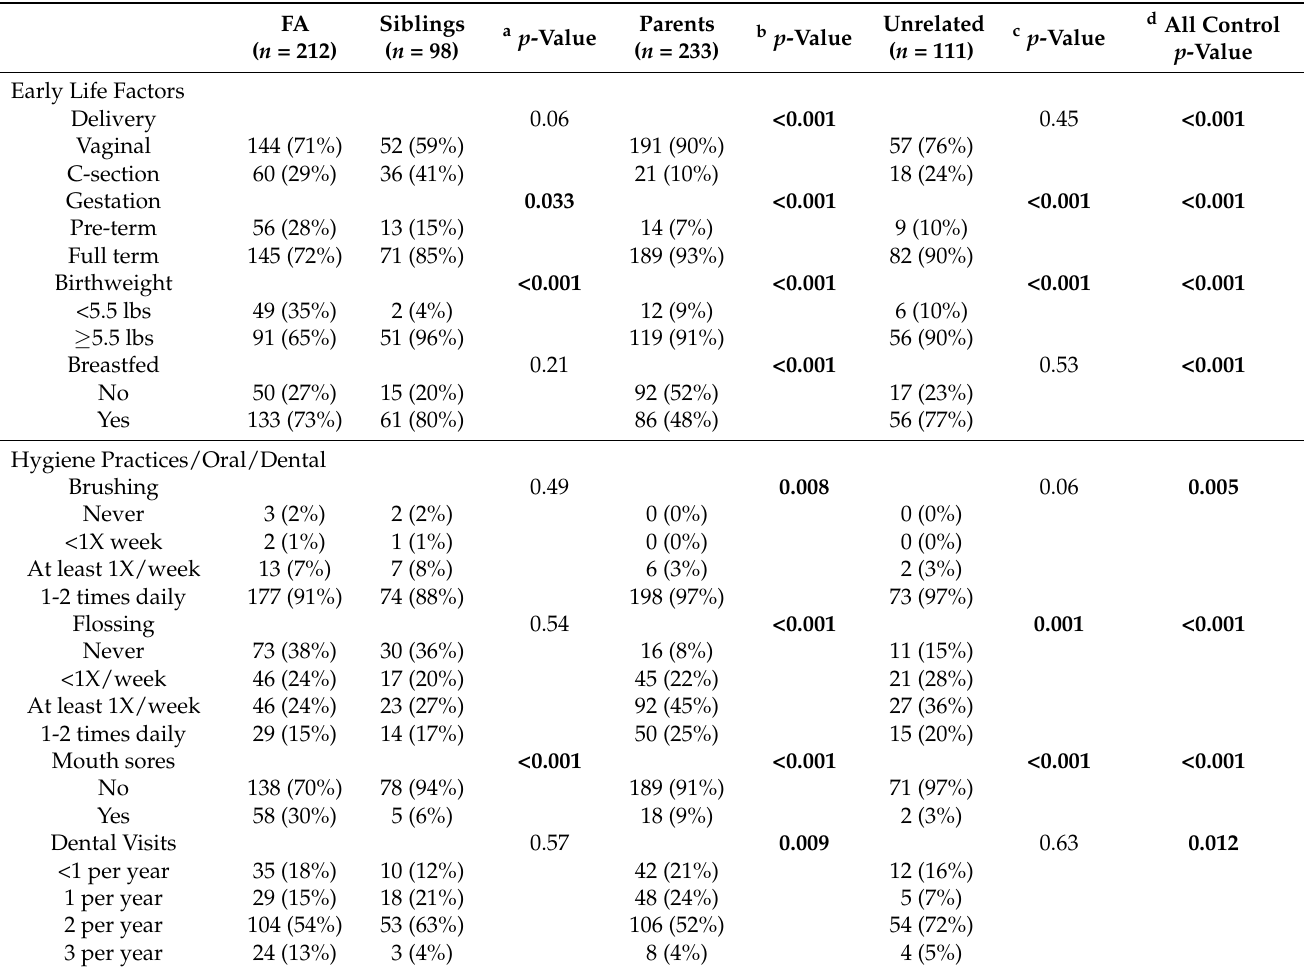
Table 3. Early and Later Life Exposures and